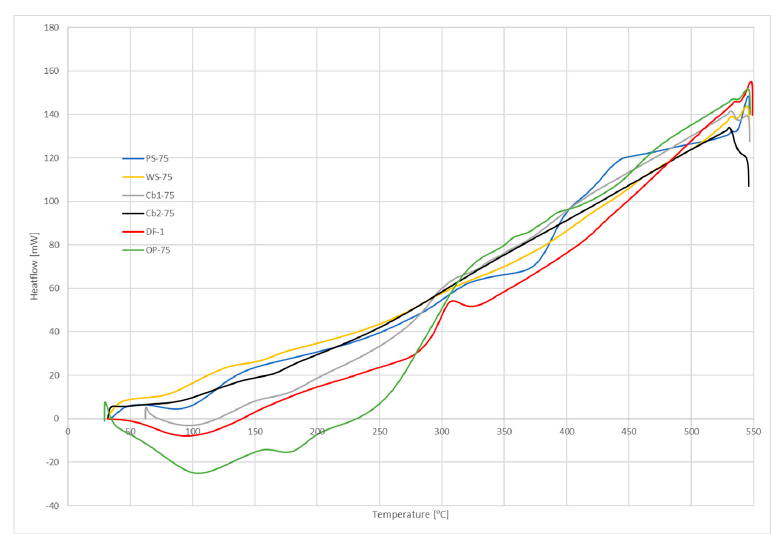
Figure 4. Differential scanning calorimetry (DSC) curves.